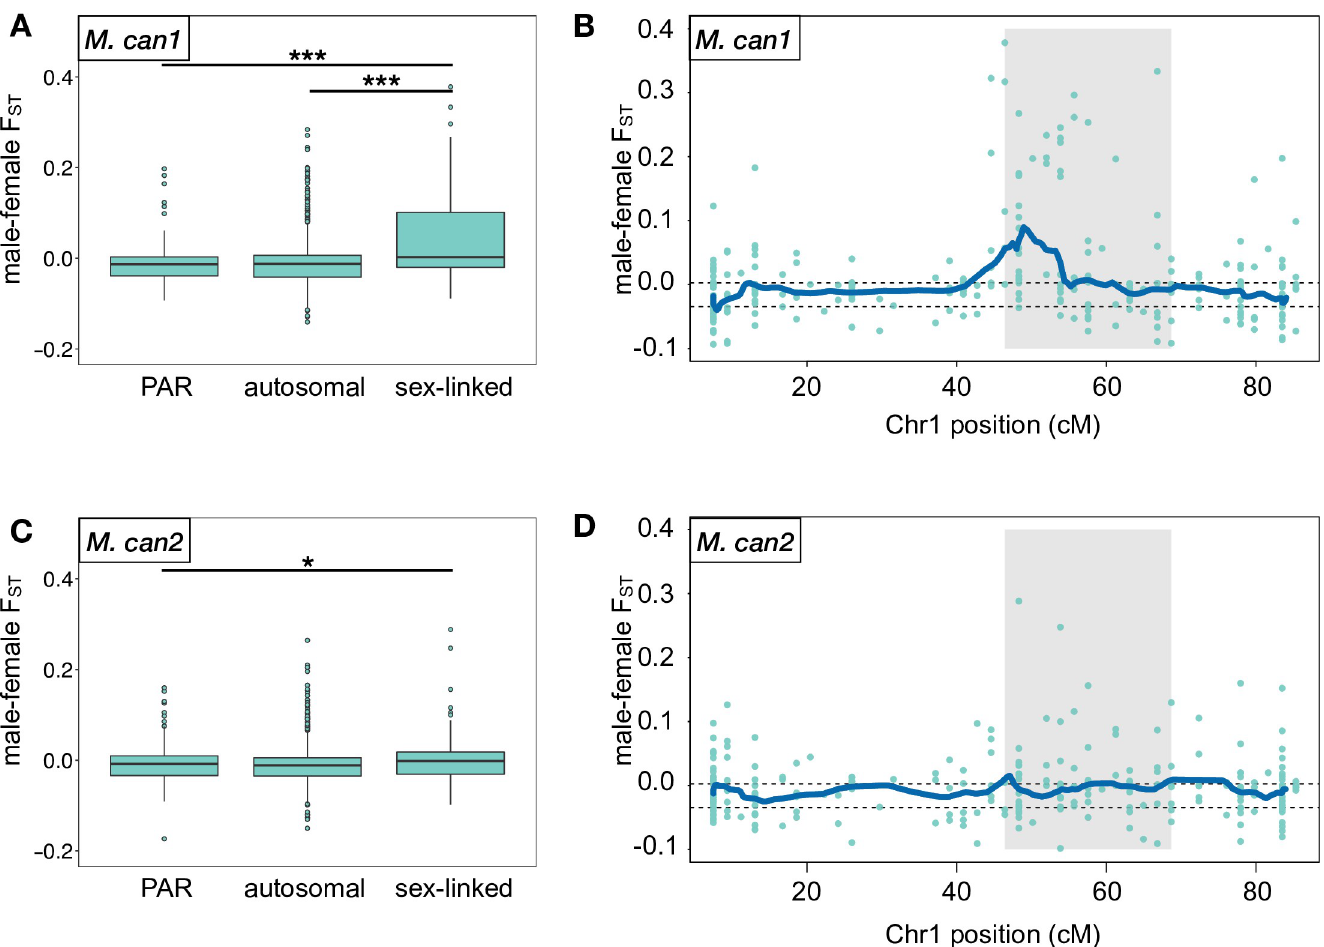
Fig 3. F ST between males and females in M . canariensis . (A) Boxplot of F ST between males and females in the M . can1 subgenome, with autosomal, pseudoautosomal, and sex-linked categories defined according to the linkage map for M . annua [60]. (B). Rolling average of 20 transcripts across linkage group 1 in the M . can1 subgenome. Grey shaded regions indicate the sex-linked region inferred for M . annua [60]. Horizontal dashed lines show 95% CI based on comparison with autosomes. (C). Boxplot of F ST between males and females in autosomal, pseudoautosomal, and sex-linked regions in M . can2 subgenome. (D) Rolling average of 20 transcripts across linkage group 1 in M . can2